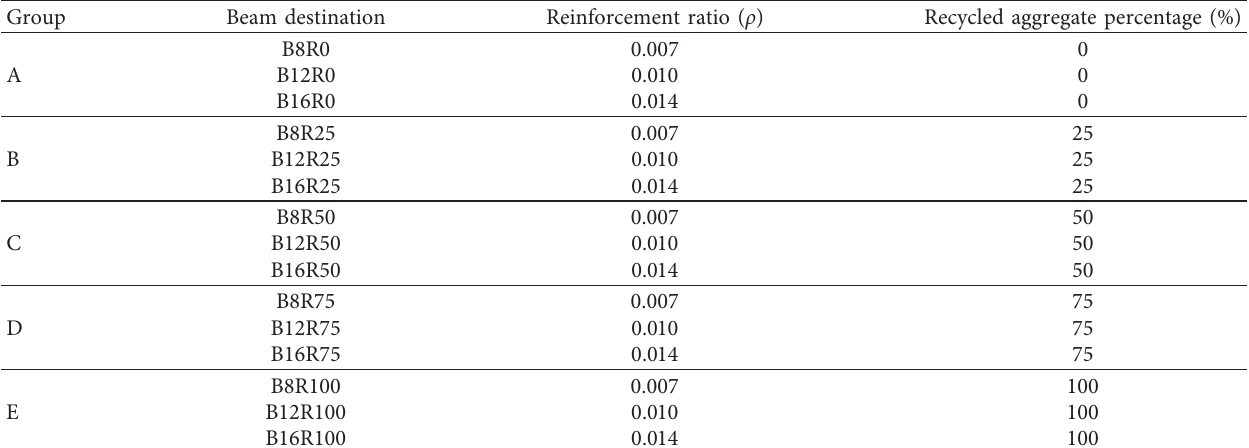
Table 1: Details of the tested beams.